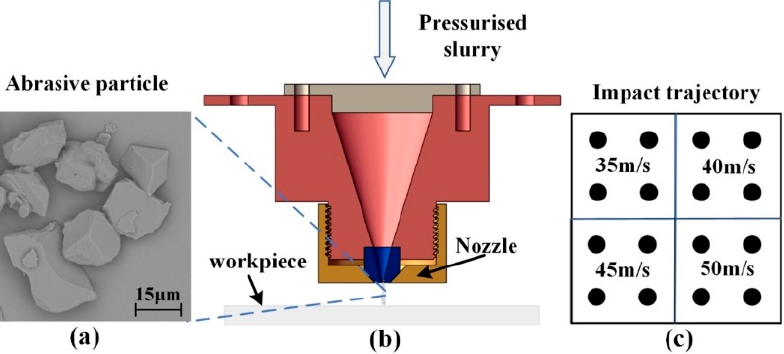
Figure 2. Schematic of experimental setup. ( a ) alumina particles ( b ) polishing nozzle and ( c ) impact test design.